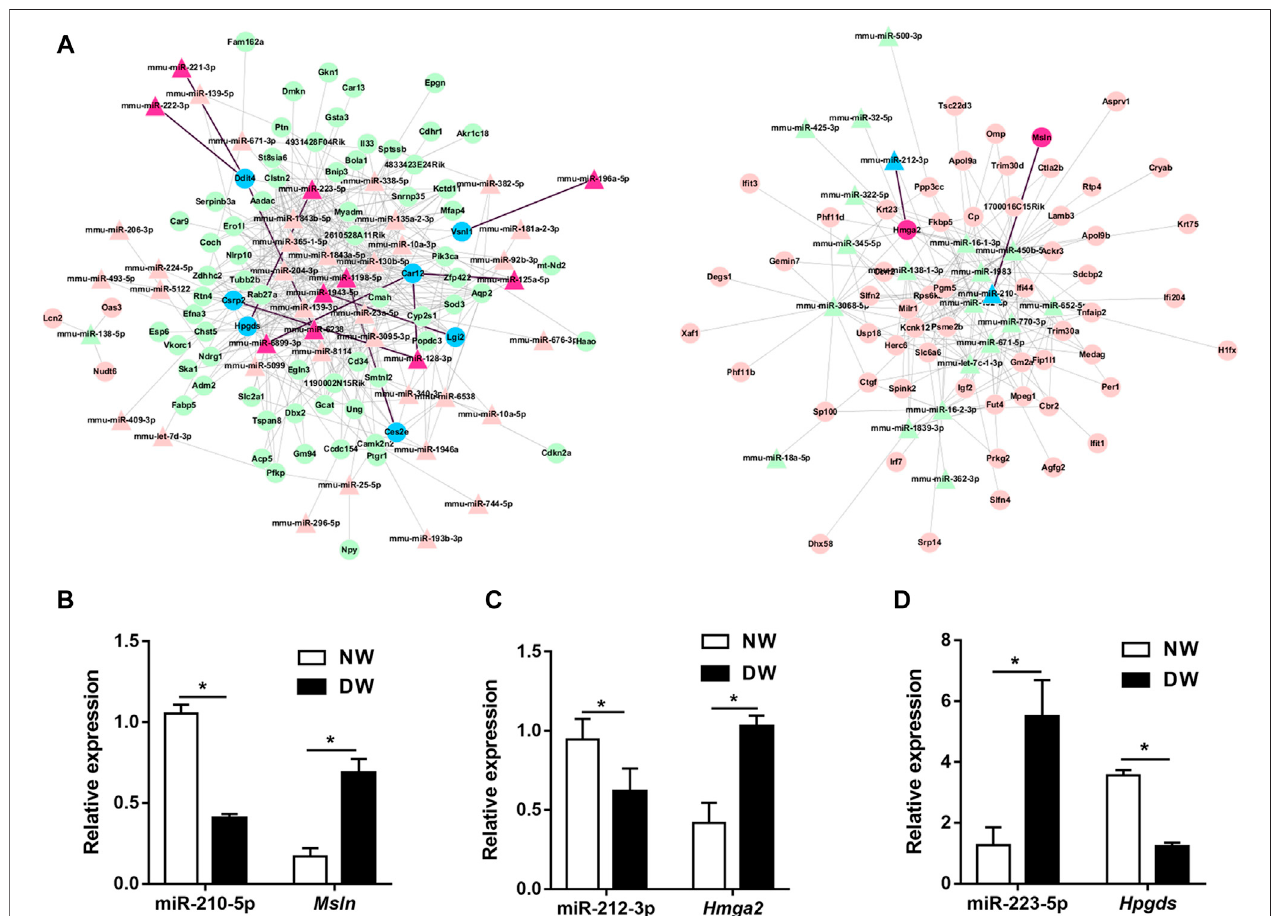
FIGURE 3 | miRNA/mRNA regulatory network analysis. (A) Interaction of the miRNA and mRNA were predicted by TargetScan. The upregulated genes are indicatedinpinkandred,whilethedownregulatedgenesareingreenandblue.Therelativelycredibleaxesare fi lteredbyTargetScanandmiRDB,andfurtherselectedby scores. Red regions, blue regions and black lines represented the fi ltered miRNA/mRNA pathways. (B – D) miR-210-5p/ Msln , miR-212-3p/ Hmga2, and miR-223-5p/ Hpgds axes were preliminarily validated by qRT-PCR. Data were analyzed by unpaired t-test. * p -value of < 0.05.